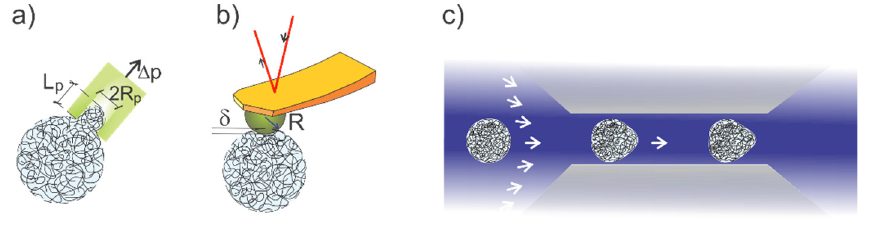
Figure 1. Schematic illustrations of micropipette aspiration ( a ), atomic force microscopy-based nanoindentation ( b ) and squeezing in microchannel confinement ( c ) for characterization of mechanical properties of microgels. In micropipette aspiration ( a ), a suction pressure ( Δ p) applied by a micropipette with inner radius R p , in contact with the microgel leads to suction with length L p of part of the microgel in the pipette. Analysis of experimentally determined L p as a function of Δ p combined with appropriate material model yields an estimate of mechanical properties; ( b ) Schematic illustration of colloidal bead (radius R) tip geometry on an AFM cantilever indenting a microgel with total indentation δ ; ( c ) Illustration of microgels in a fluid stream in a constriction channel with cross-sectional dimensions larger than the microgel being deformed due to the distribution of stress imposed on the microgels by the flow field.